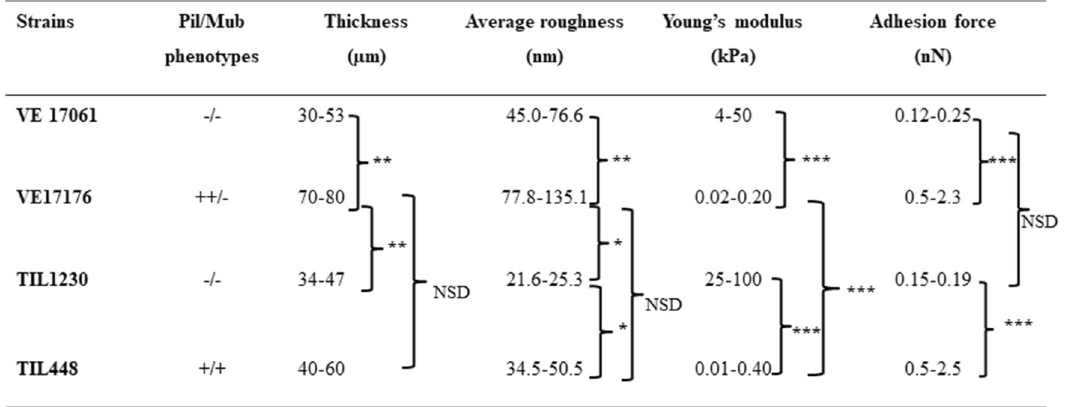
Table 2. Summary table of results: biofilm thickness, average roughness, Young’s modulus and adhesion force are reported for the four studied strains. For each parameter, a statistical analysis was performed by the ANOVA test at the threshold of 5% (*), 1% (**) and 0.1% (***). NSD: no significant difference.